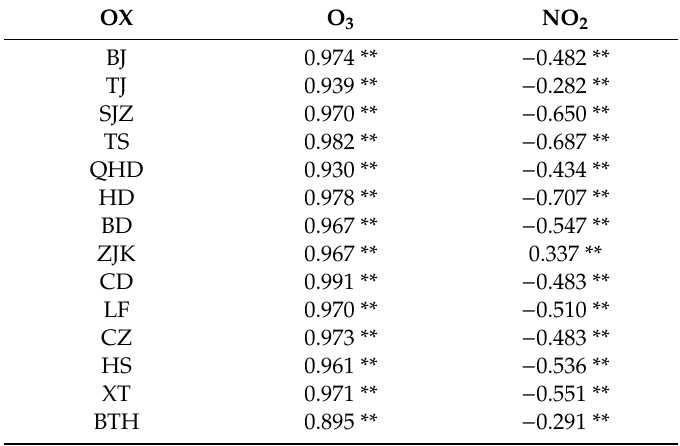
Table 1. Spearman correlation coe ffi cients between OX and O 3 or NO 2.